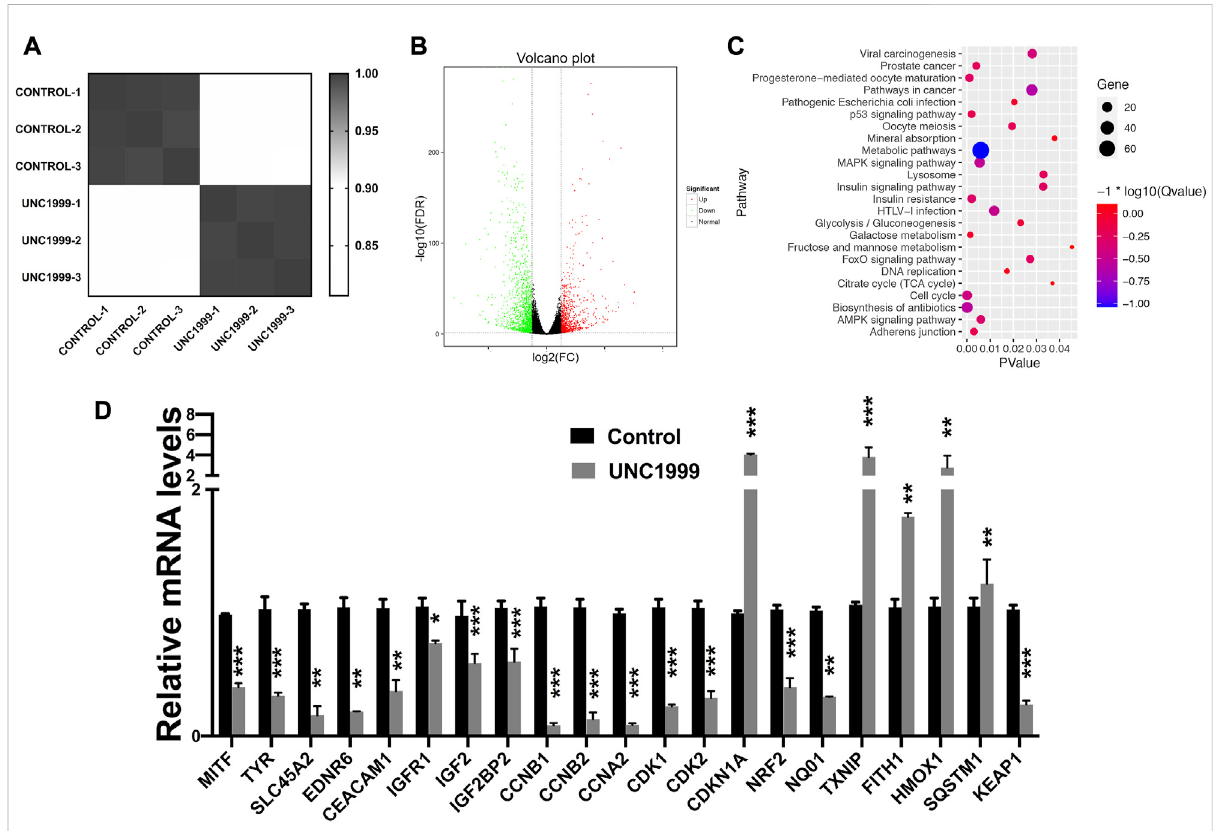
UNC1999 affects the cell cycle in OMM1 cells. (A) Cluster analysis of gene expression of the treatment of control and UNC 1999. (B) 207 upregulated genes and 449 downregulated genes in Volcano Plot. (C) Gene enrichment analysis using DAVID. (D) The relative mRNA levels of indicated DEGs and indicated treatment group was analyzed by RT-PCR. Data are expressed as mean ± SD from at least three independent experiments with triple replicates per experiment. (* p < 0.05, ** p < 0.01, *** p <